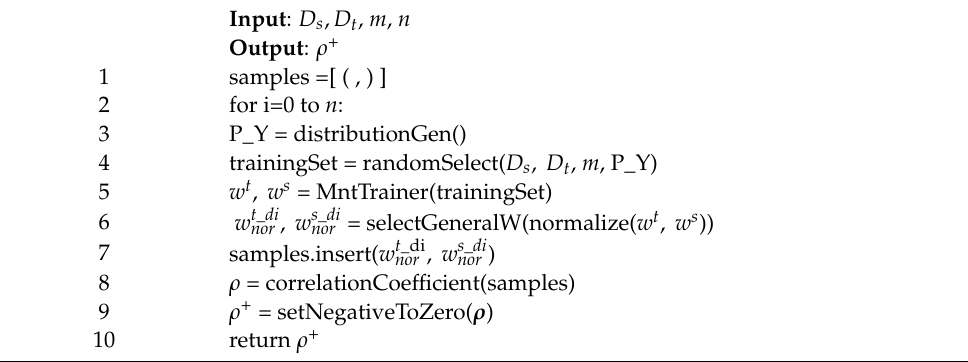
Algorithm 1 Calculate Correlation Coefficient between D s and D t